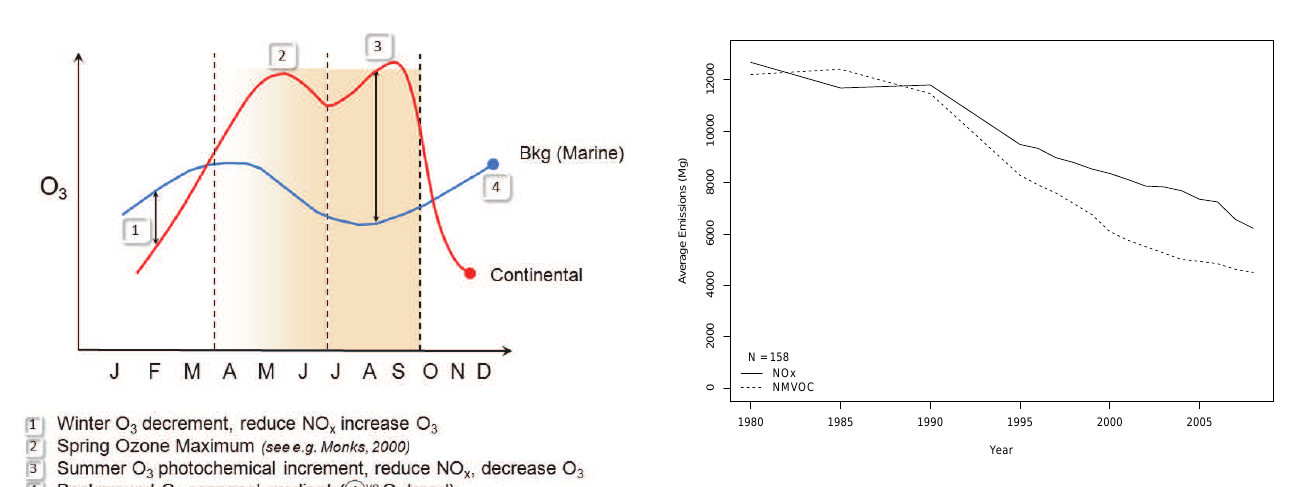
13 Fig. 1. A schematic diagram of an idealized marine background and European ozone seasonal cycle